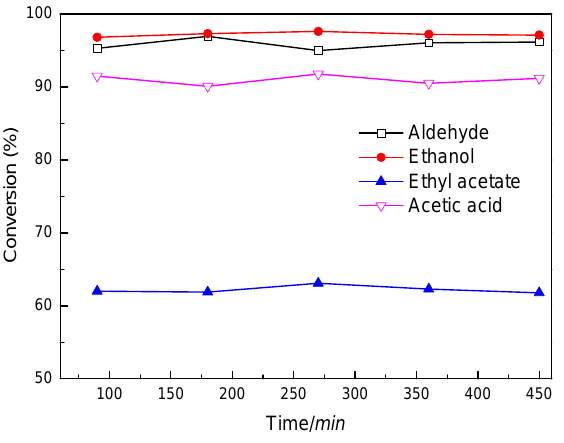
Figure 5. Effect of functional group on conversion. Reaction conditions: T = 270 °C, WHSV = 2 h − 1 , H 2 /feedstock = 400, P = 4.0 MPa.